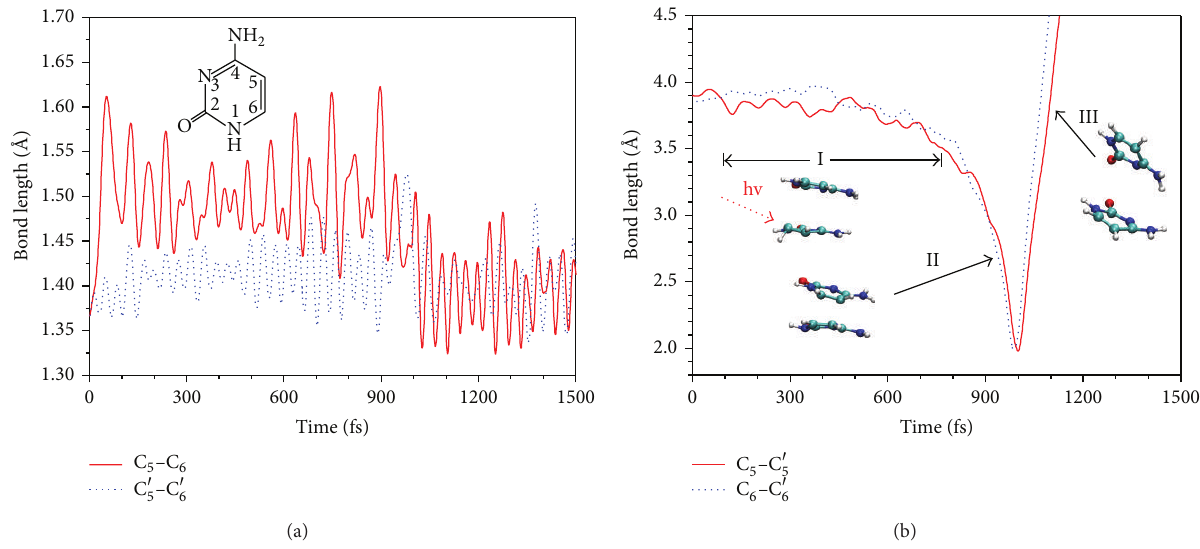
Figure 2: (a) The variations with time of the lengths between the C 5 and C 6 atoms and the C 󸀠 5 and C 󸀠 6 atoms. (b) The variations with time of the lengths between the C 5 and C 󸀠 5 atoms and the C 6 and C 󸀠 6 atoms in two stacked cytosines molecules.